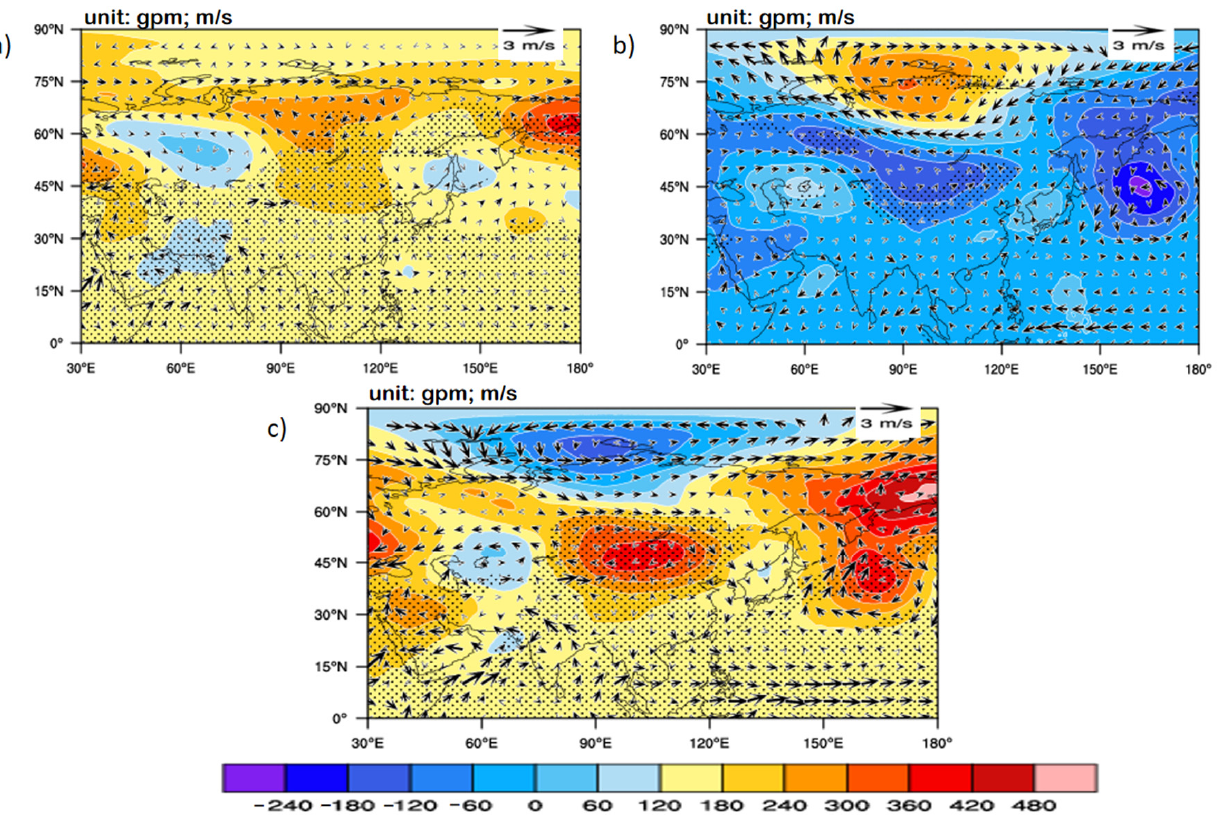
Figure 7. Composite 500 hPa geopotential height anomaly (gpm, shaded) and 850 hPa wind anomaly (m/s, vectors) of the two rainfall patterns in Northeast China during 1961 − 2019: ( a ) pattern A; ( b ) pattern B; and ( c ) pattern A minus pattern B. The dots indicate that the 500 hPa height anomaly exceeds the 95% confidence level; red (blue) shaded areas: positive (negative) values. The vector values were estimated using Student’s t -test.